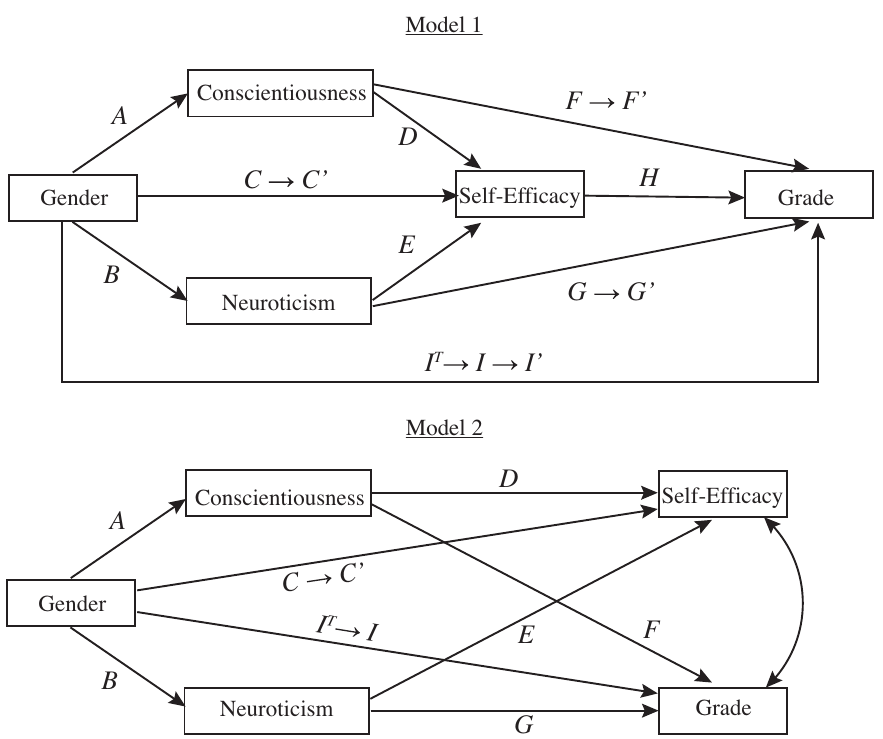
FIG. 2. Path models showing the relation of gender, personality, self-efficacy, and physics course grade. The notation C → C 0 shows the change in the coefficient relating gender to self-efficacy before the addition of mediating variables ( C ) and after the addition of these variables ( C 0 ). The notation I T → I → I 0 shows the relation between gender and grade without mediators ( I T ), with only personality as mediating variables ( I ), and with both personality and self-efficacy as mediating variables ( I 0